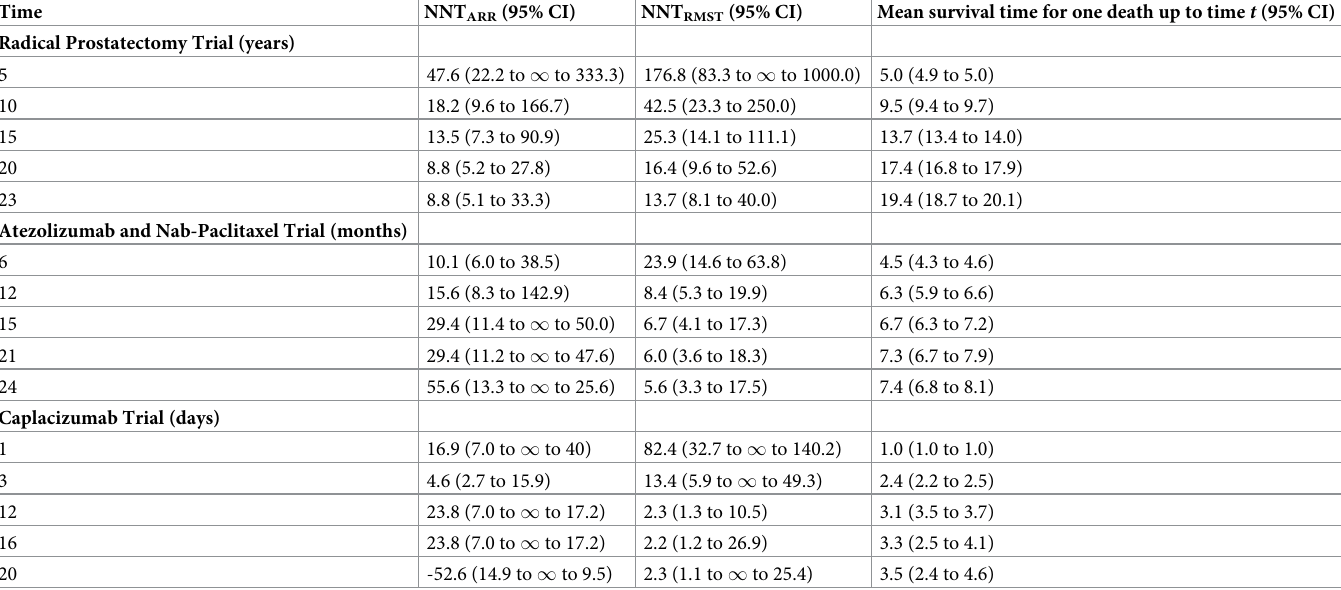
Table 1. Comparison of the NNT ARR and NNT RMST based on three real trials